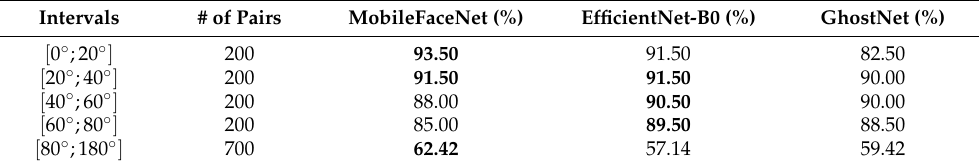
Table 9. Verification performance over the five intervals with the proposed evaluation